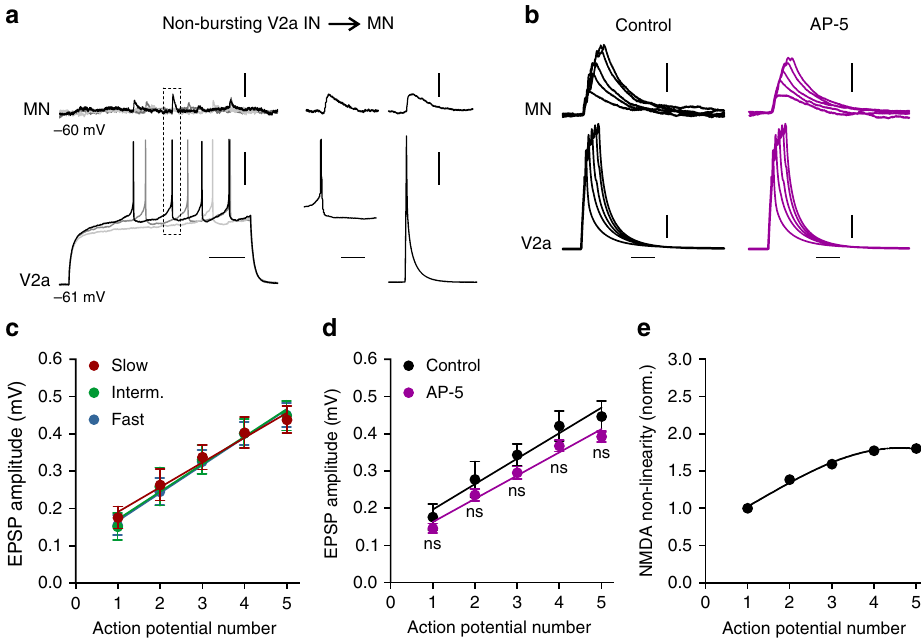
Fig. 5 Absence of NMDA-dependent short-term potentiation in non-bursting-type V2a interneurons. a Repetitive action potentials in a non-bursting-type V2a interneuron elicited small amplitude EPSPs in a target motoneuron, similar to those produced by single action potentials. b Stimulation of a non- bursting-type V2a interneuron with current pulses with increasing duration to mimic burst fi ring did not produce any NMDA-dependent non-linear summation. c The EPSP amplitude showed a linear summation as a function of the increased number of action potentials in non-bursting-type V2a interneurons of all modules ( n = 6 in each module; error bar re fl ects the s.e.m.). d Blockade of NMDA receptors did not signi fi cantly decrease the amplitude of the EPSPs (interaction: F 4,110 = 0.095, P = 0.9837; two-way repeated-measures ANOVA; n = 12; error bars in the graph re fl ect the s.e.m.). e There was no NMDA-dependent ampli fi cation of the summation of the EPSPs. Scale bars, 100 ms, 10 ms, 10 mV, 0.2